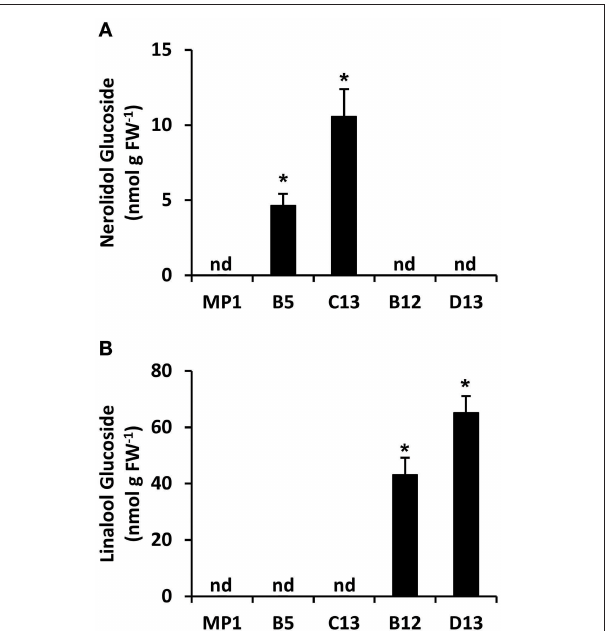
FIGURE 5 | Metabolic profiling of terpene glucosides in AmNES/LIS-1 (lines B5 and C13) and AmNES/LIS-2 (lines B12 and D13) fruits. Glucosides were extracted from ripe fruits of MP1 control and representative transgenic lines, then enzymatically hydrolyzed. The released nerolidol (A) and linalool (B) aglycones were analyzed by GC-MS. Data are means ± SEM ( n = 3). * P < 0.05 AmNES/LIS-1/-2 lines relative to the MP1 control by Student’s t -test. FW, fresh weight; nd, not